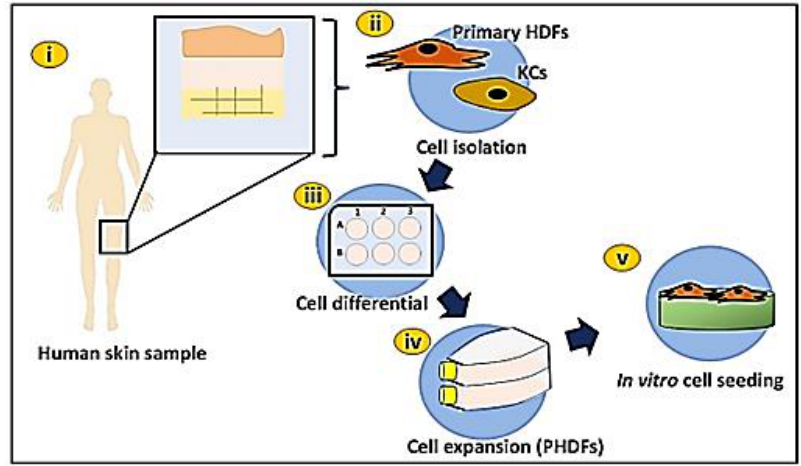
Figure 1. Experimental design for human skin cell isolation: (i) collection of human skin sample, (ii) cell isolation: primary HDFs and KCs, (iii) cell differential prior primary HDFs expansion, (iv) pri- mary HDFs expansion in T75 cell culture flasks, (v) in vitro cell seeding (primary HDFs) on hydro- gel.